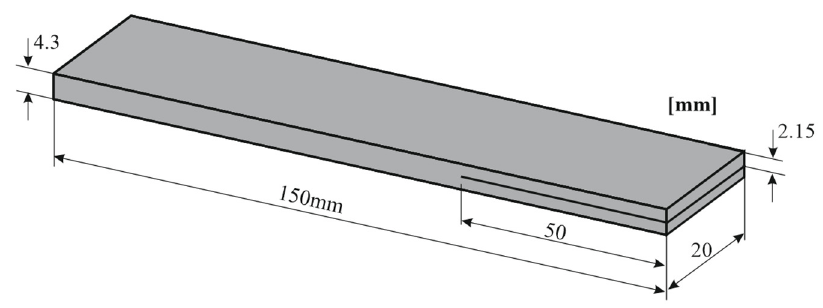
Figure 1. Schema of the specimen.